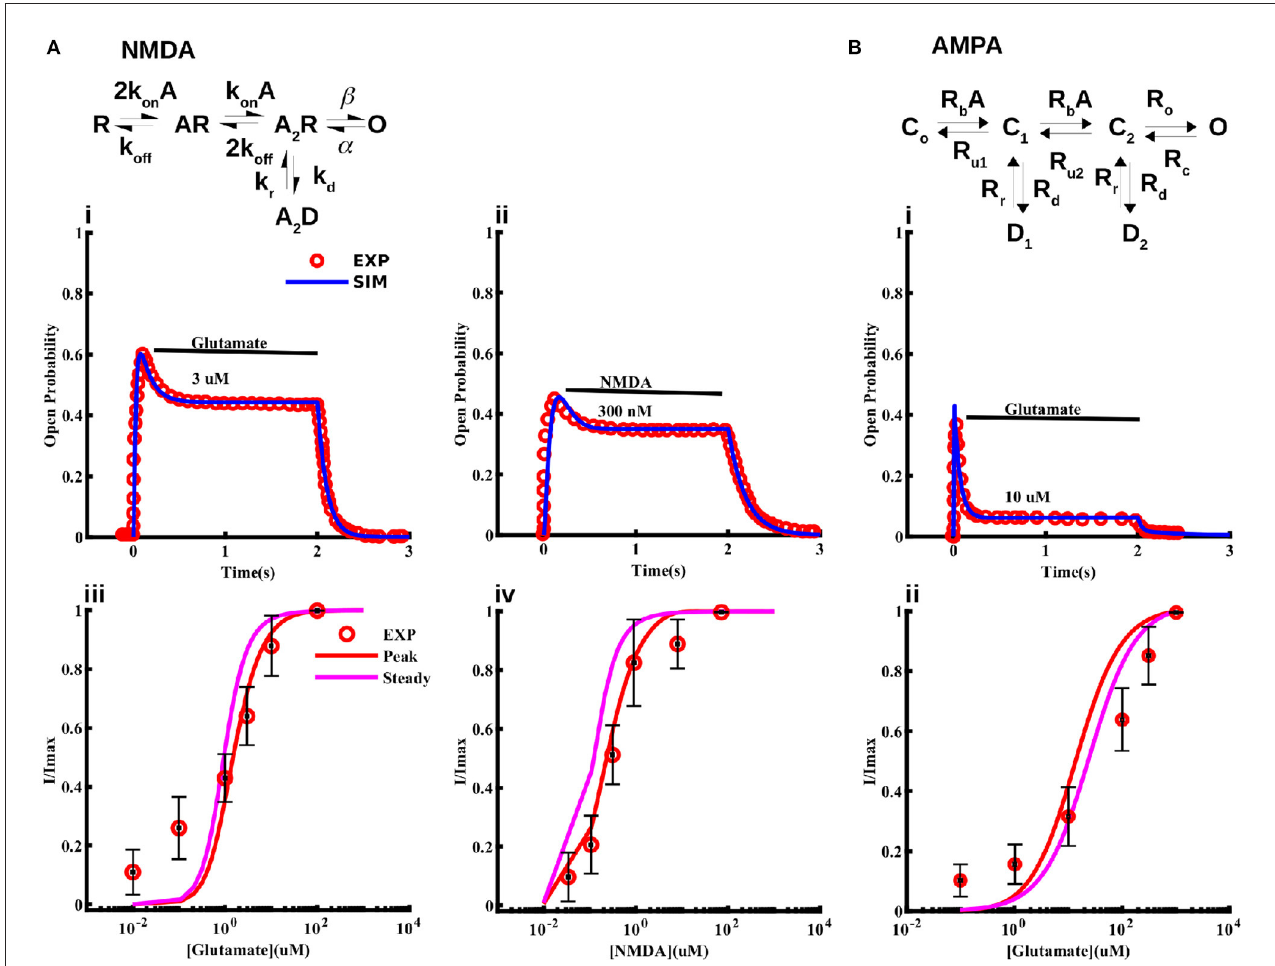
FIGURE2 Models for NMDA and AMPA receptors in cortical astrocytes. Schematic of the 5-state model used for the NMDA receptor (A) and 6-state model used for the AMPA receptor (B) . The model fits to current traces from NMDA receptors in cortical astrocytes at different concentrations of glutamate (Ai, Aiii) and NMDA (Aii, Aiv) . In Ai and Aii 3 µ M glutamate and 300 nM NMDA was applied for 2 s, respectively. (Bi) Sample trace from AMPA receptors given by the model and observed experimentally in response to 10 µ M glutamate application for 2 s, and (Bii) normalized current through AMPA receptors as a function of glutamate concentration. In (Aiii, Aiv, Bii) we show both the peak and steady state values of the current from the model. Experimental data shown for comparison is extracted from Lalo et al. (2006).